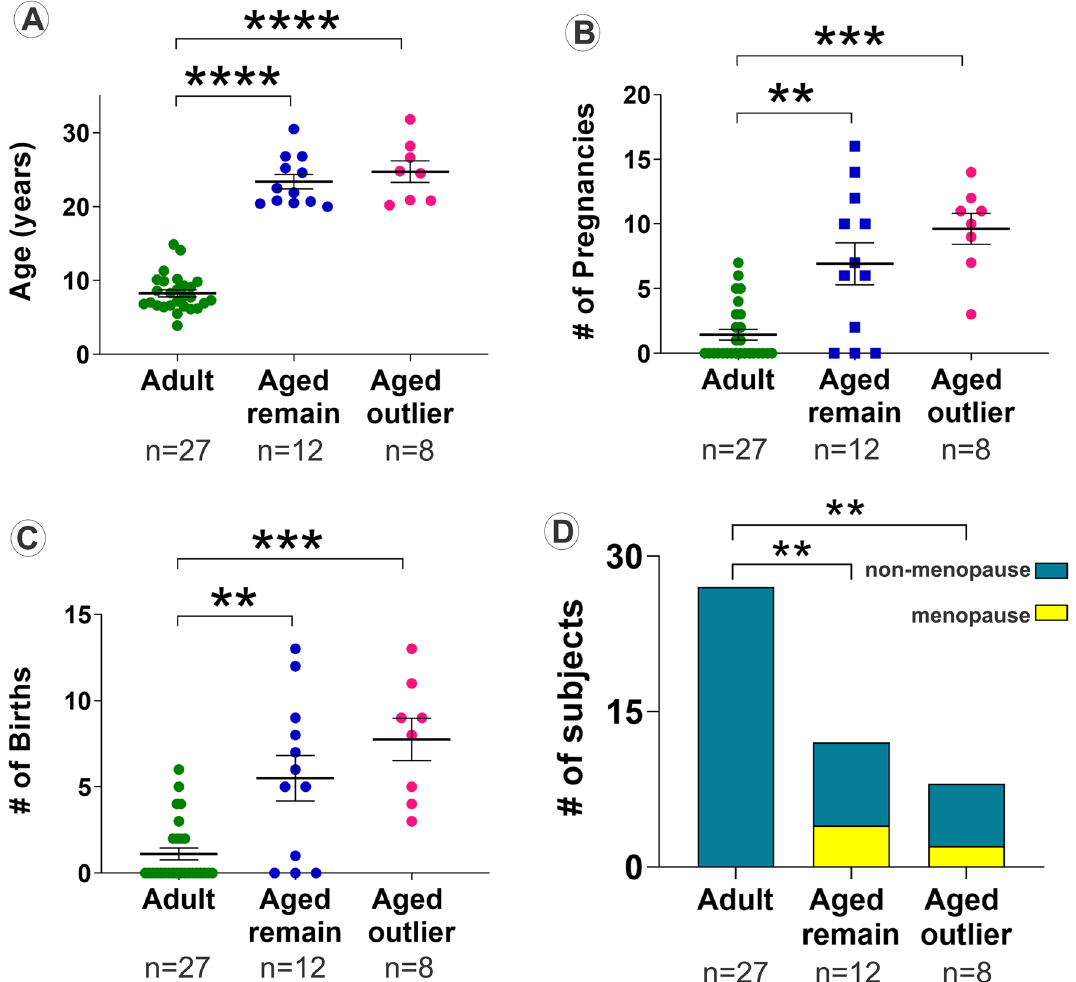
Figure 5. Demographics. By experimental design, both aged remain and aged outlier cohorts were significantly older compared to the adult animals ( p < 0.0001), but there was no detectable difference in age between the aged remain and aged outlier groups ( A ). The number of prior pregnancies was significantly higher for aged remain ( p < 0.01) and aged outliers ( p < 0.001) compared to adult animals, but there was no detectable difference in the number of pregnancies between the aged remain and aged outlier groups ( B ). The number of births was also significantly higher for aged remain ( p < 0.01) and aged outliers ( p < 0.001) compared to adult animals, but there was no detectable difference in the number of births between the aged remain and aged outlier groups ( C ). A significant proportion of animals demonstrated menopause in the aged remain ( p < 0.01) and aged outlier groups ( p < 0.01) compared to adult animals, but there was no difference in the proportions of post-menopausal animals between the aged remain and aged outlier groups ( D ). Data plots are presented as mean ± SE, and statistics are shown as ** indicating p < 0.01, *** indicating p < 0.001, and **** indicating p < 0.0001 between